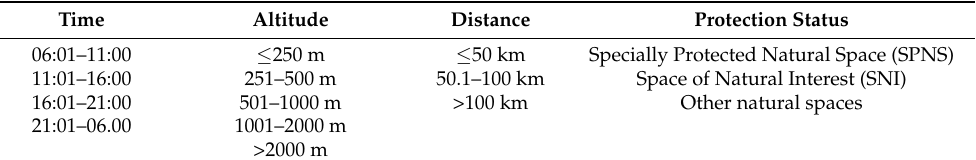
Table 1. Timeslots, altitude and distance thresholds, and natural area protection status. Time Altitude